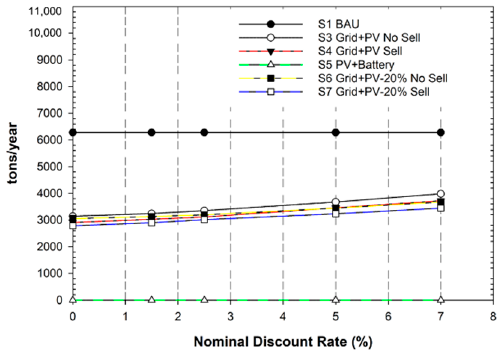
Figure 12. Carbon dioxide emissions in tons per year for all scenarios.